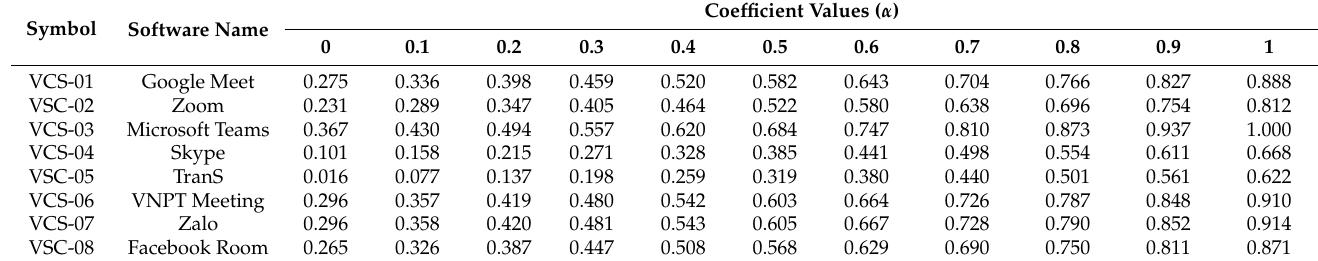
Table 10. The fluctuation coefficient value of G-EDAS.